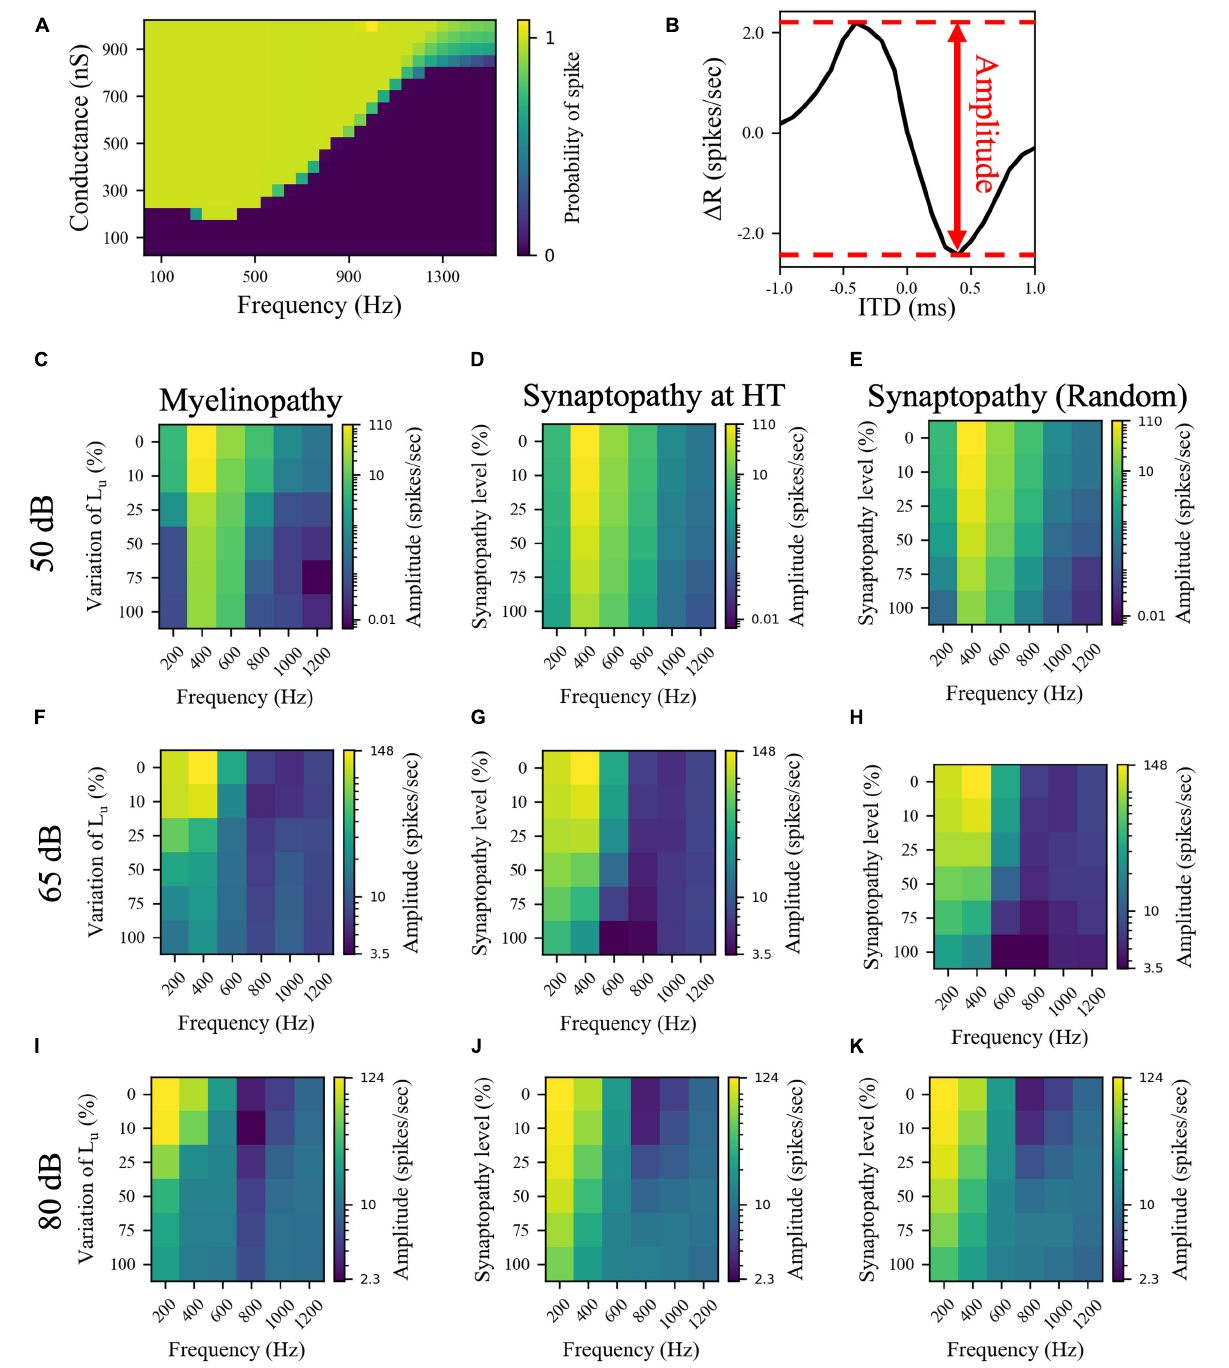
Frontiers in Neural Circuits |